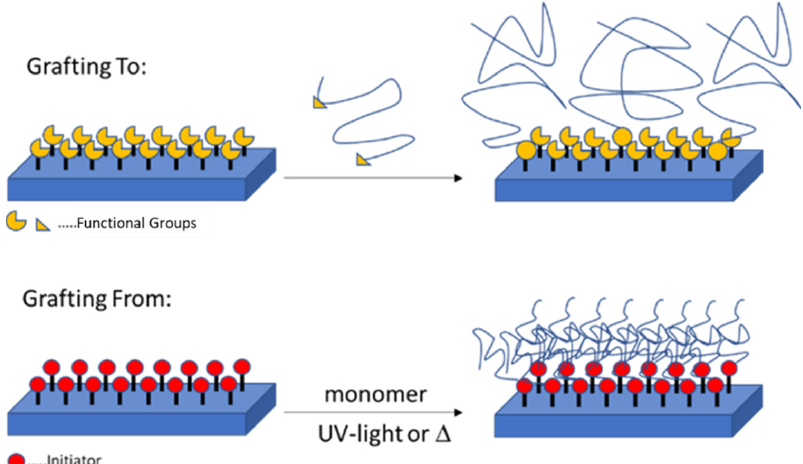
Figure 1. Schematic illustration of the “grafting from” and the “grafting to” approach (modified from ref. [8]). Blue lines indicate grafted polymer chains.